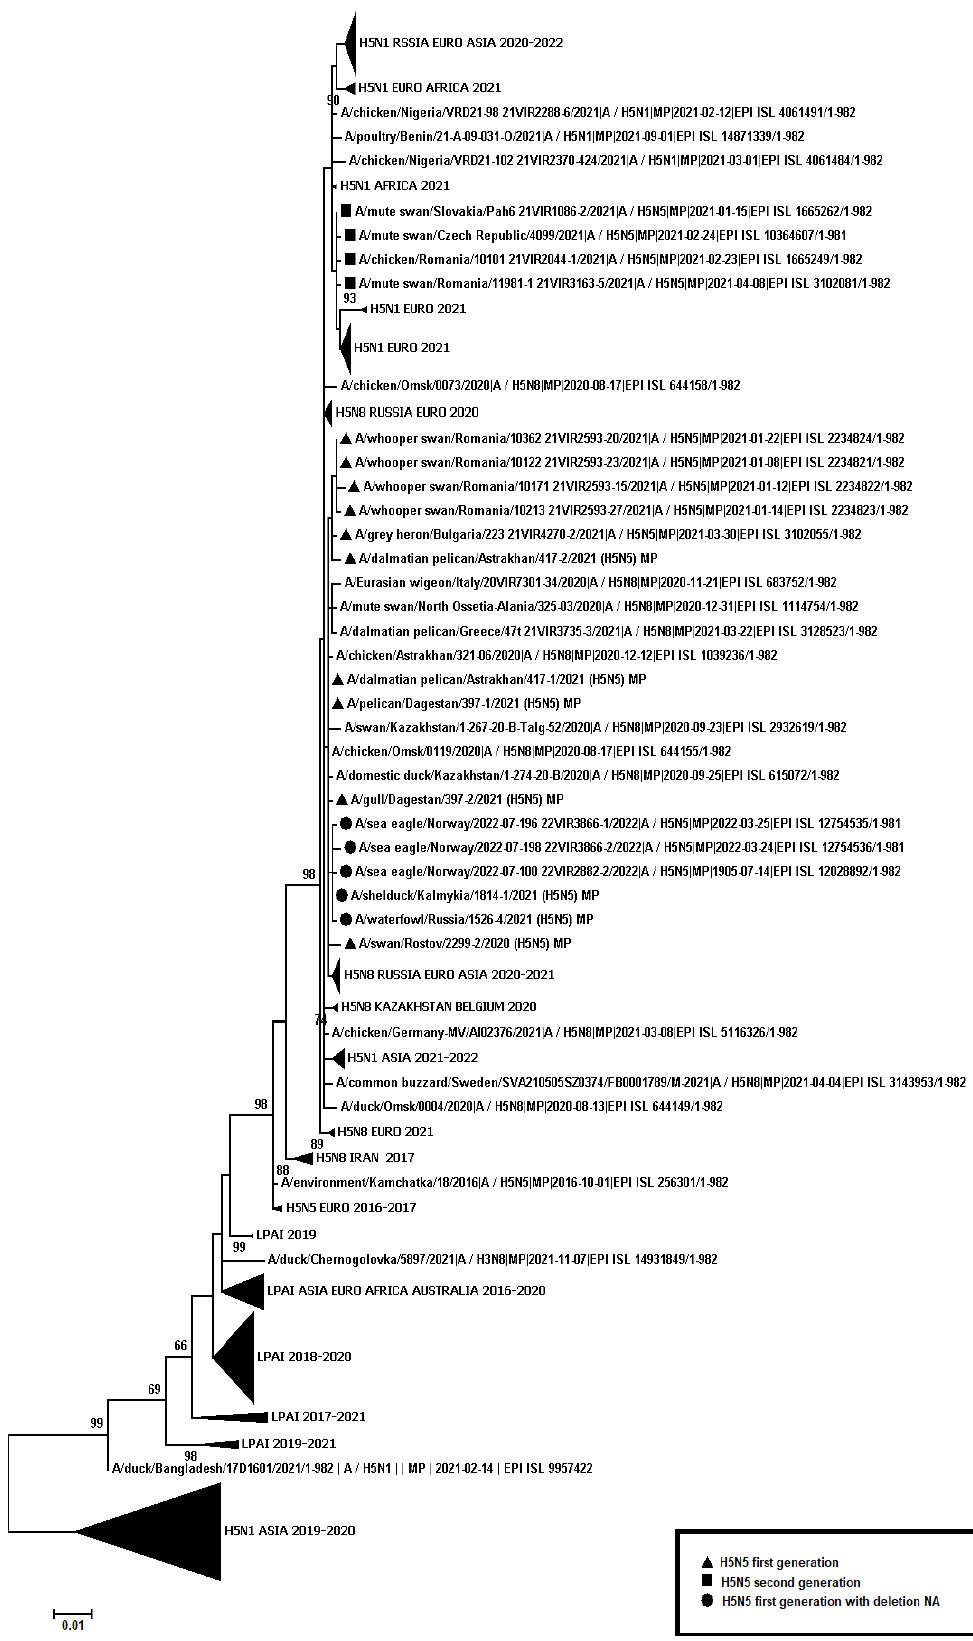
Figure 2. Phylogenetic tree constructed using the NJ method, based on the nucleotide sequence of the MP gene fragment (1–982 b.p. ORFs) of the AIV subtype.